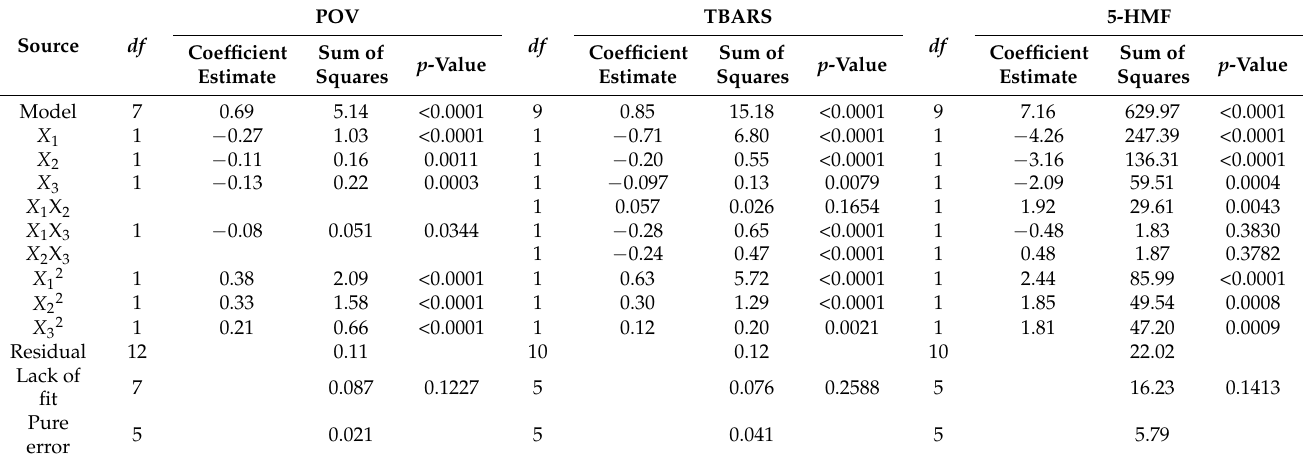
Table 4. Analysis of variance (ANOVA) of the fitted second-order polynomial model for POV, TBARS, and